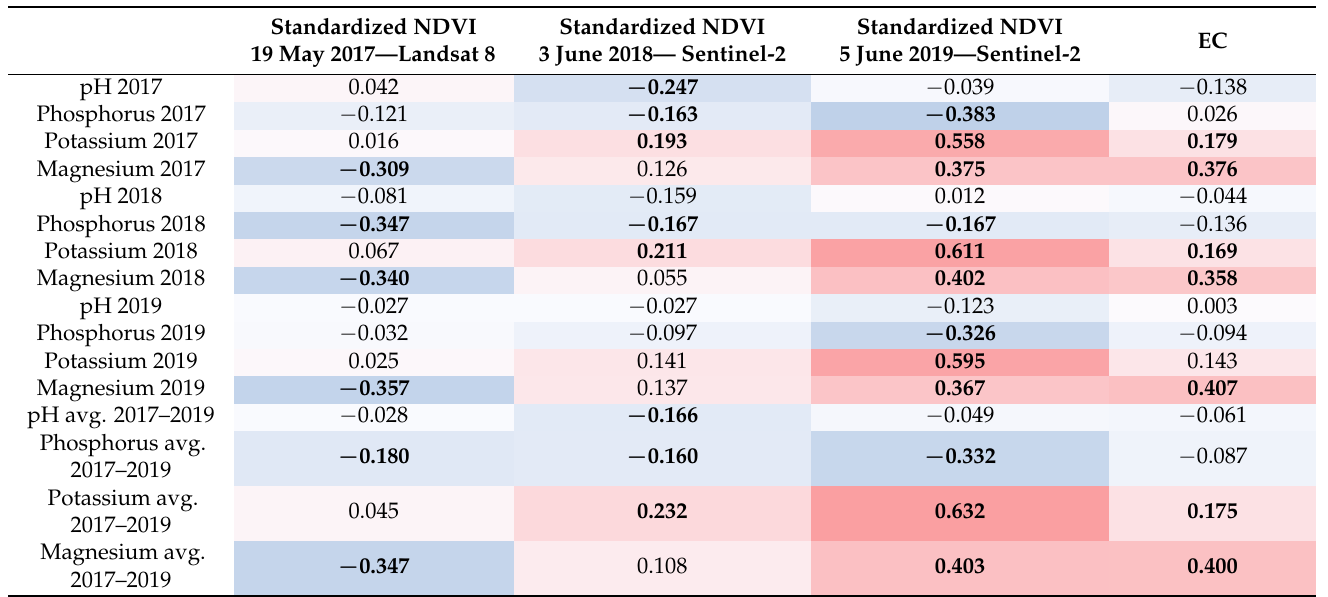
Table 7. Correlation coefficients between EC and standardized NDVI with soil pH and nutrients content for barley (significant correlations at 0.05 significance level are in bold; color background scale for correlations the same as in Table